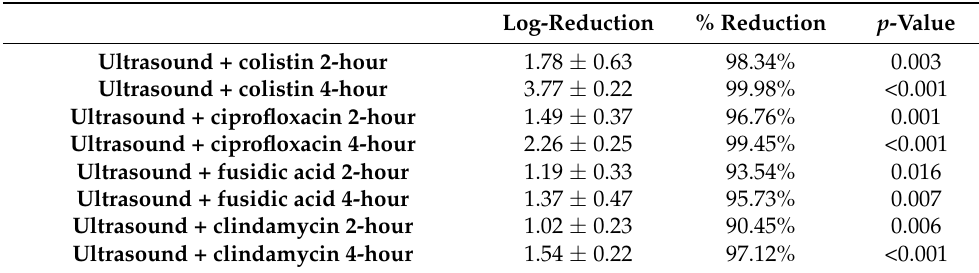
The combined effect of ultrasound and antibiotic treatment compared to 4-hour antibiotic